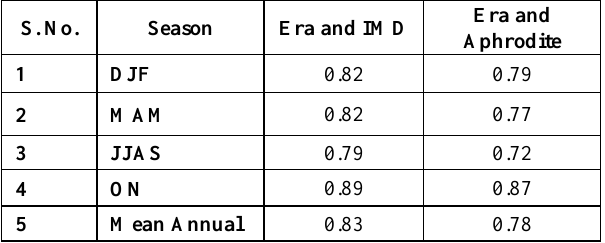
Table 2. Correlation coefficient between ERA-Interim, IMD, APHRODITE rainfall products